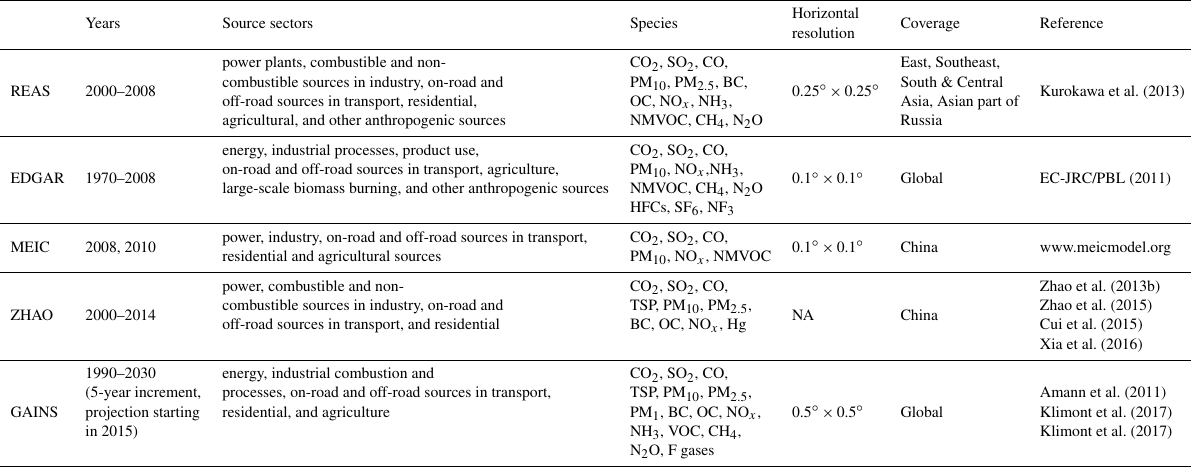
Table 1. Description of emissions inventories used for this